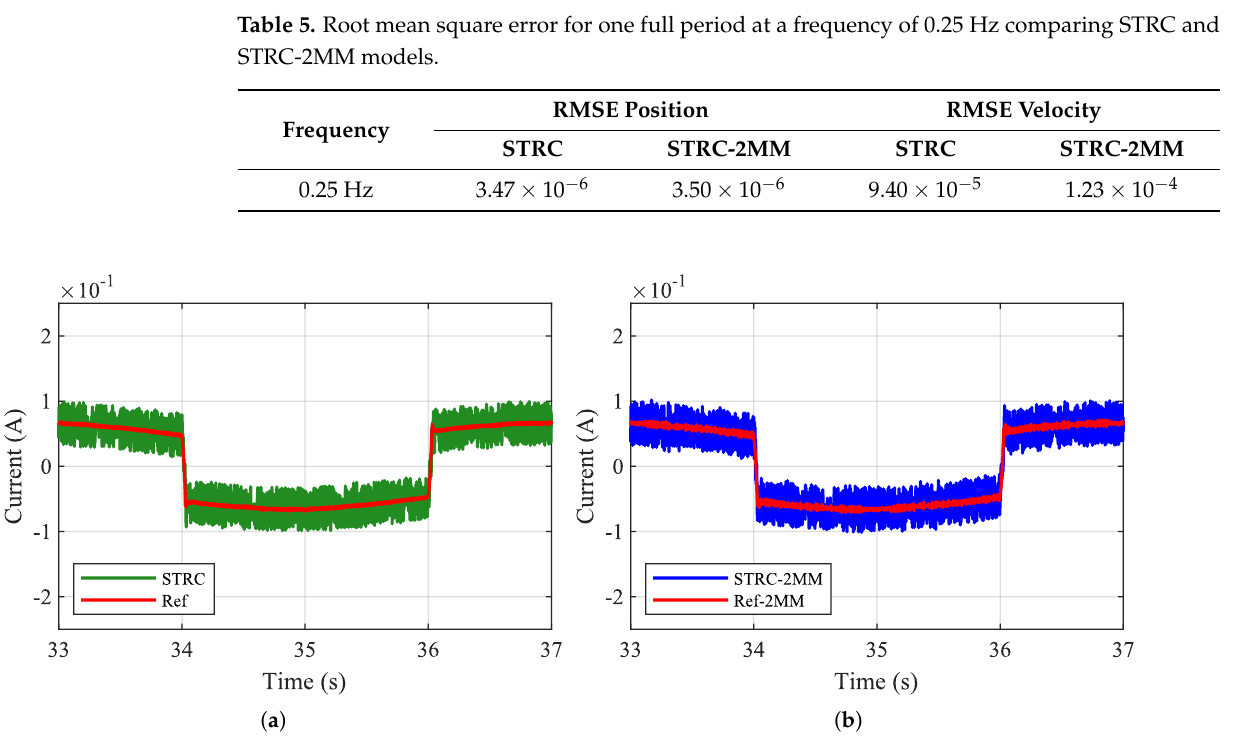
Figure 20. Simulation waveform comparison at 0.25 Hz. ( a ) STRC hysteresis current-control signals; ( b ) STRC-2MM hysteresis current-control